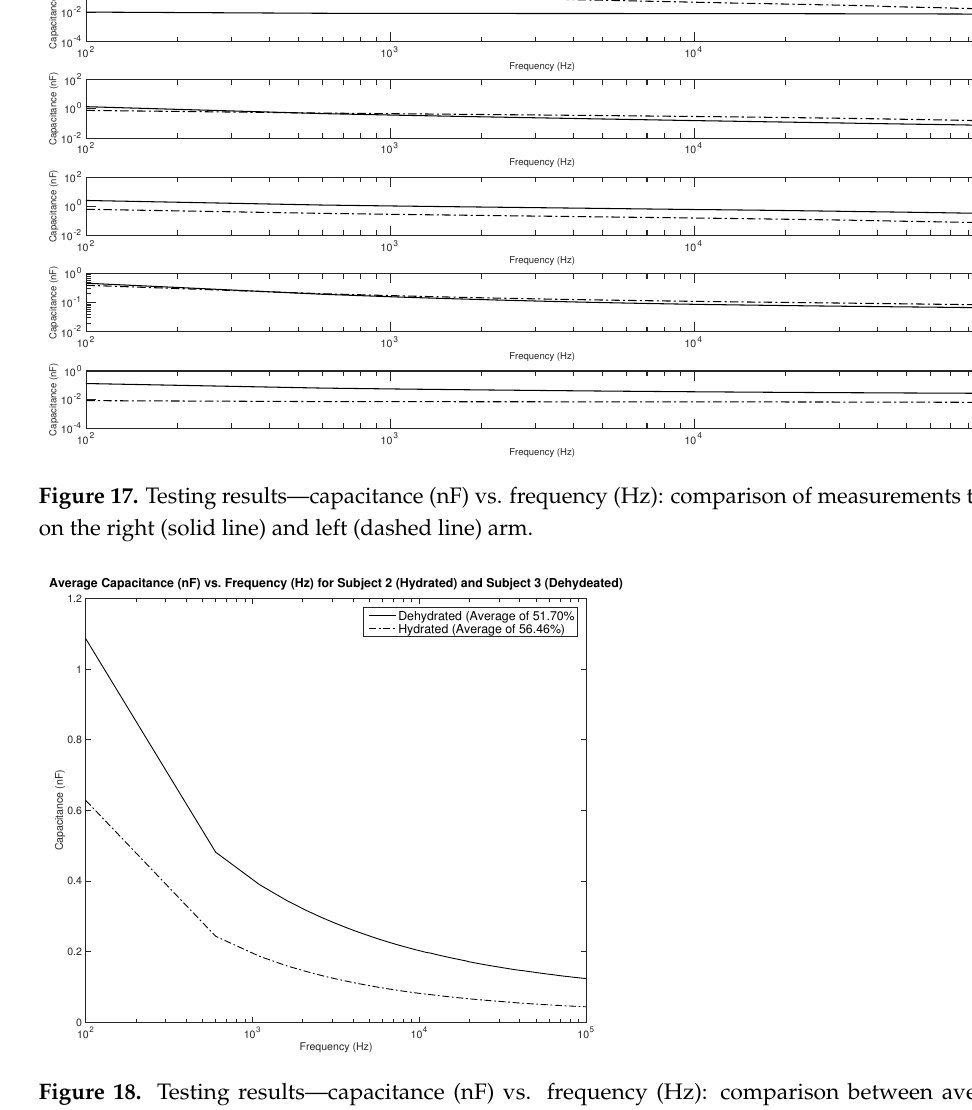
Figure 18. Testing results—capacitance (nF) vs. frequency (Hz): comparison between average measurement of hydrated and dehydrated subjects (Both